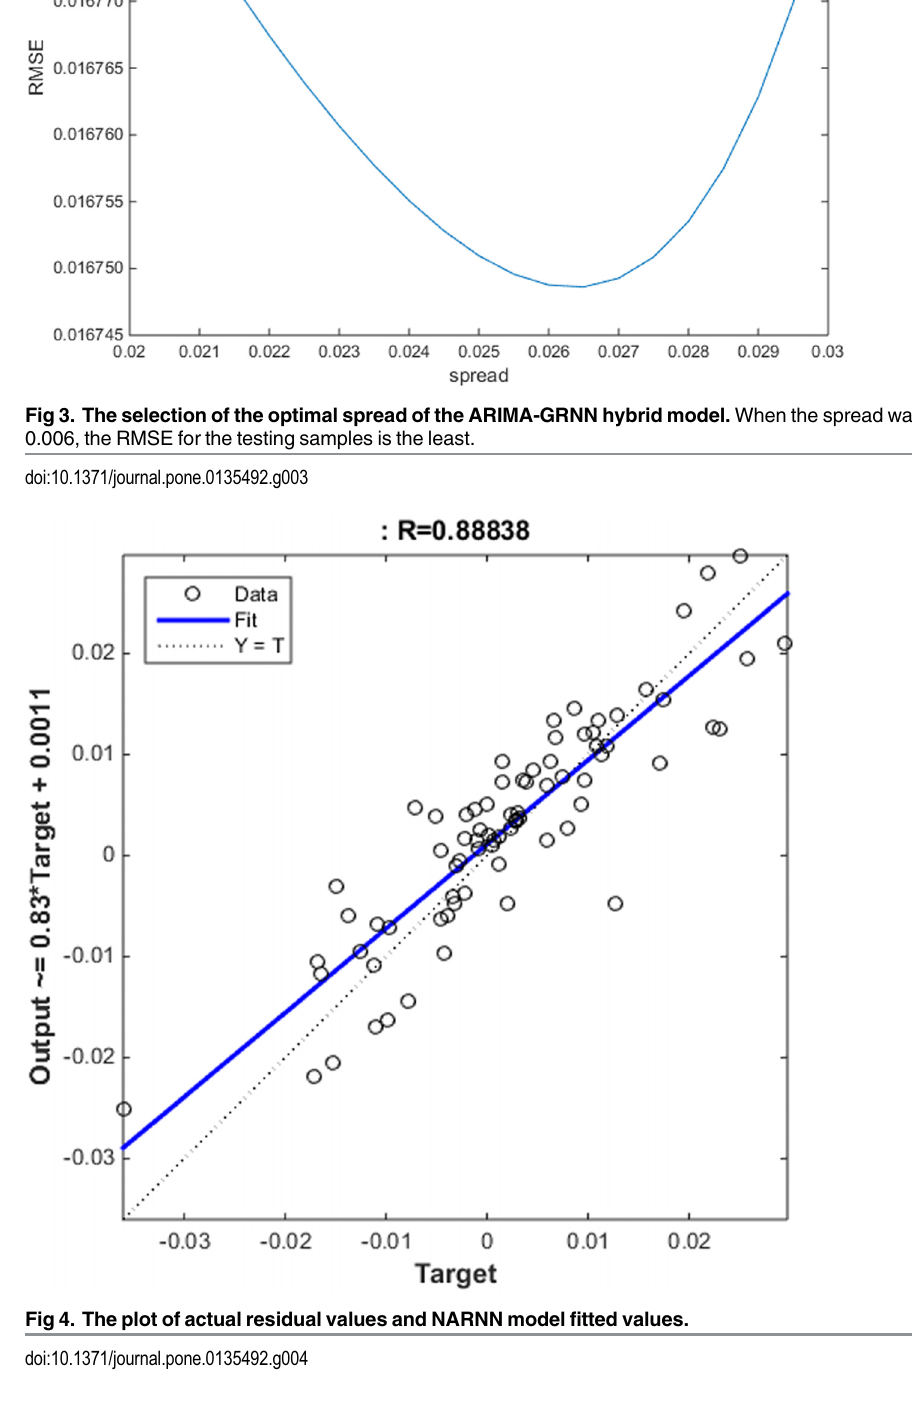
PLOS ONE | DOI:10.1371/journal.pone.0135492 August 13,